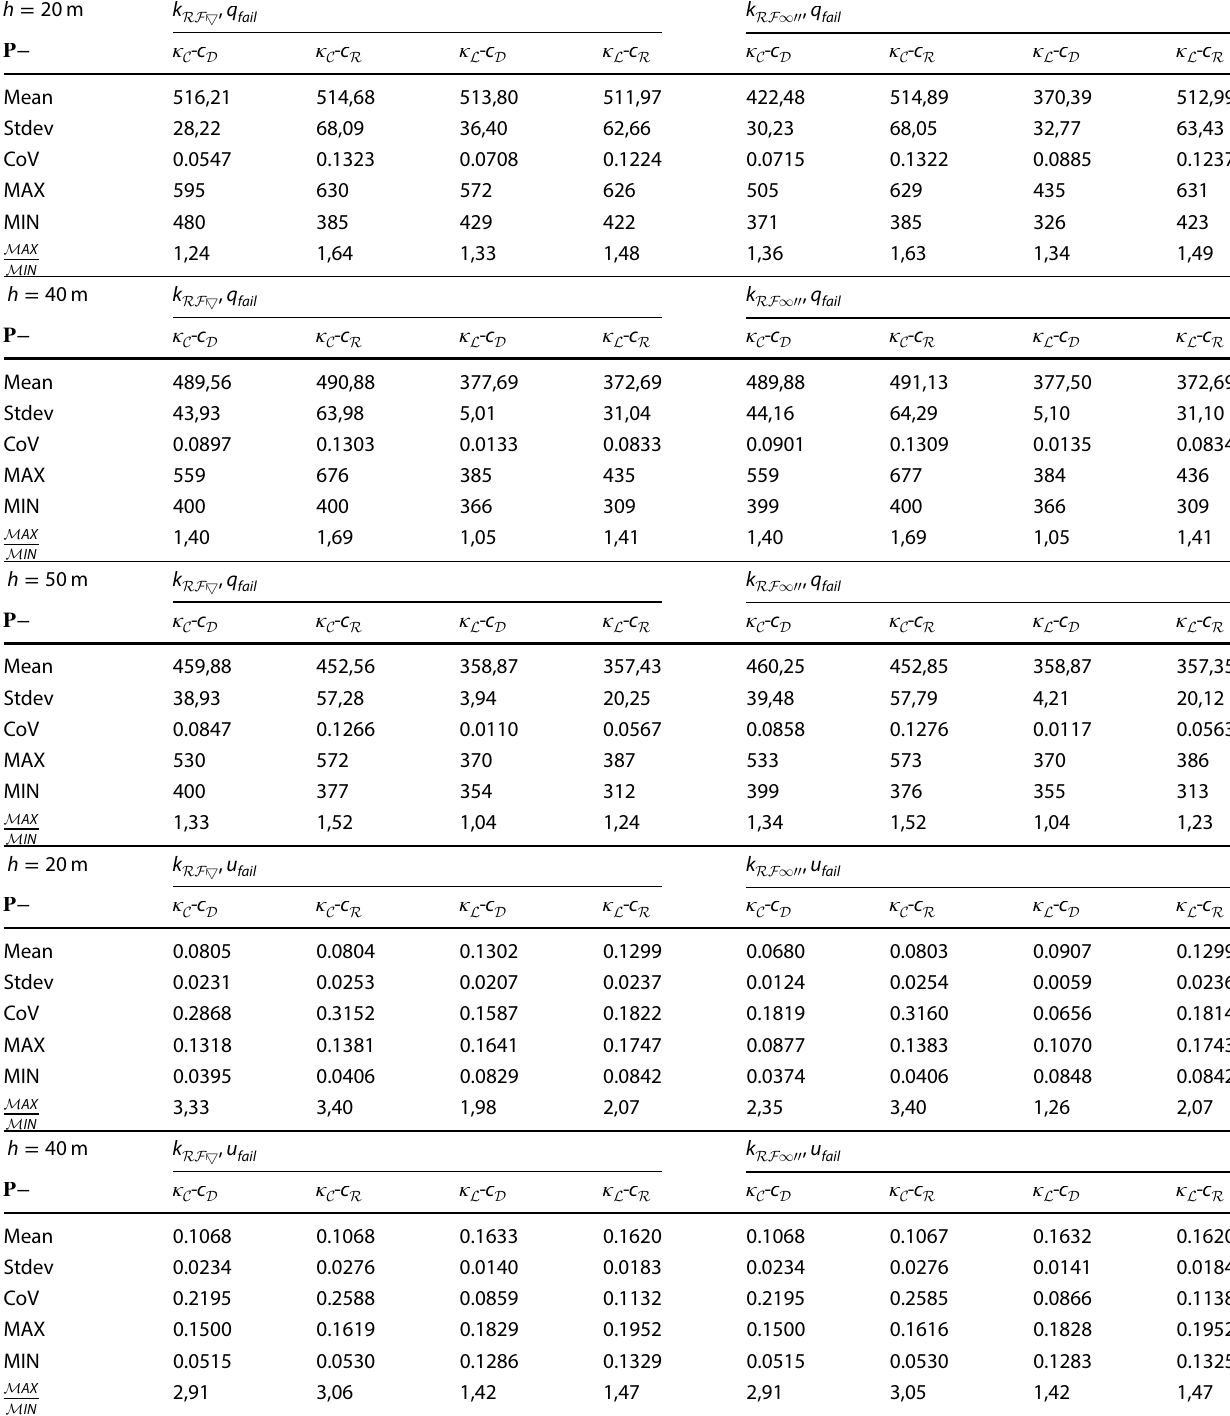
Table 6 Monte Carlo results for the failure load (KPa) (up) and failure displacement (m) (down) for porous analyses with linear and constant distribution for